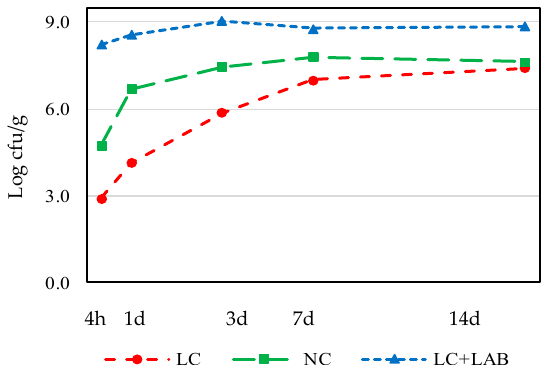
Figure 6. Counts of LAB during incubation of chouriço batter made from low contaminated meat ( LC ), normal contaminated meat ( NC ), and low contaminated meat with LAB added ( LC + LAB ). Combined results of samples with or without nitrite plus nitrate and water, artificial wine solution (AWS), or wine ( n = 24).